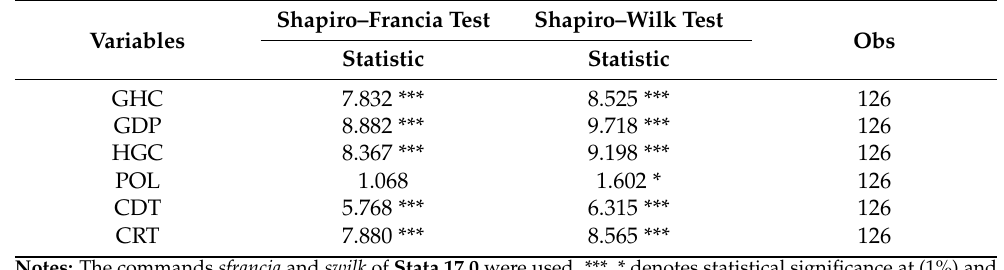
Table 4. Normal distribution tests.